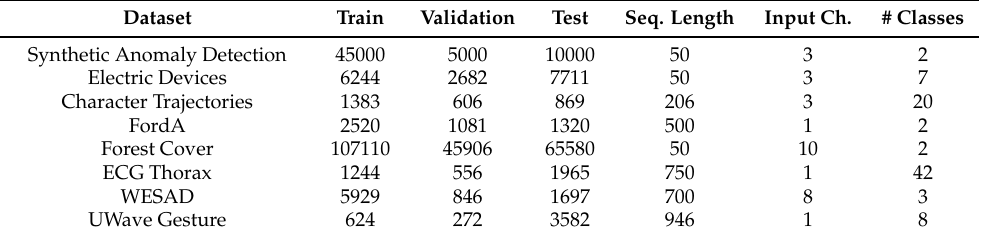
Table 1. Dataset